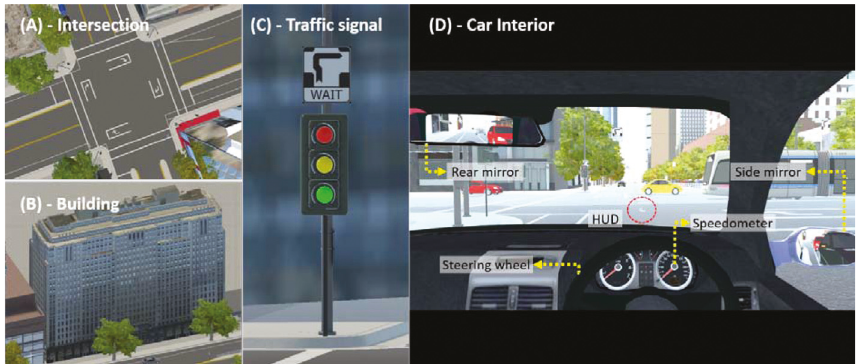
Figure 3: Objects in the simulator. (a) Intersection. (b) Building. (c) Traffic signal. (d) Car interior.